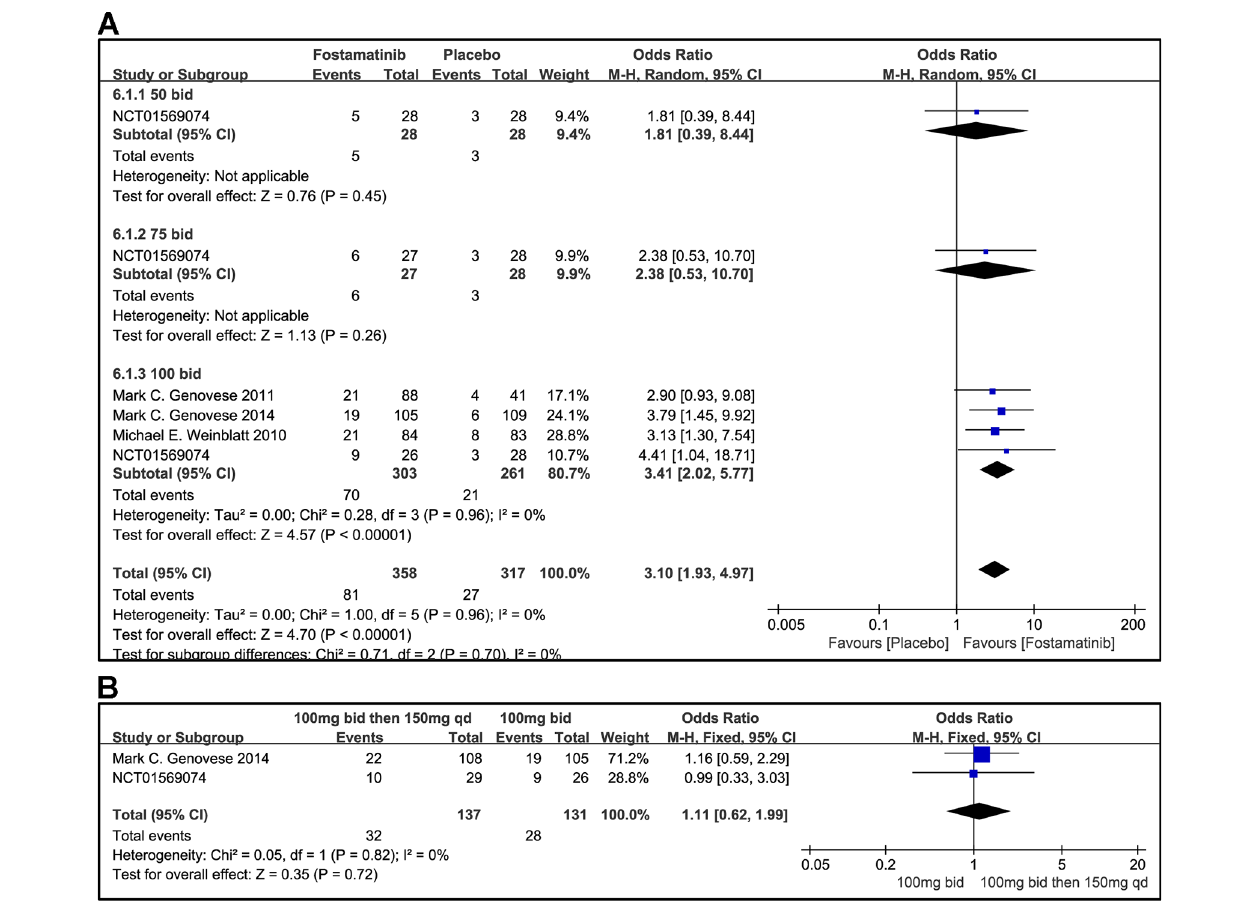
FIGURE 8 | Forest plots for the effect of multiple doses on DAS28-CRP ≤ 3.2 at different time points. (A) Subgroups administered multiple doses (50, 75, and 100 mg bid) of fostamatinib compared to placebo at 24 weeks; (B) 100 mg bid for 4 weeks followed by 150 mg bid vs. 100 mg bid at 12 and 24